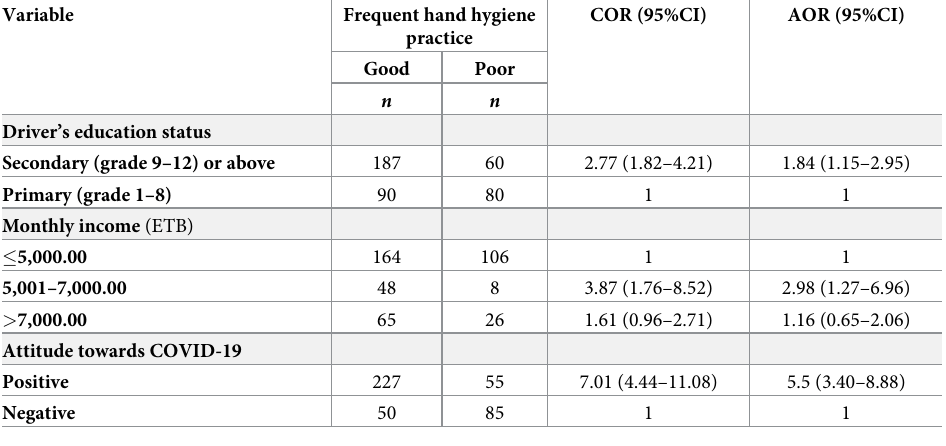
1, reference category; ETB, Ethiopia